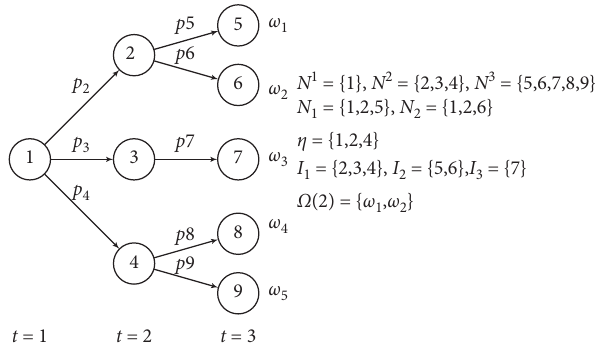
Figure 1: Scenario tree representation of stochastic